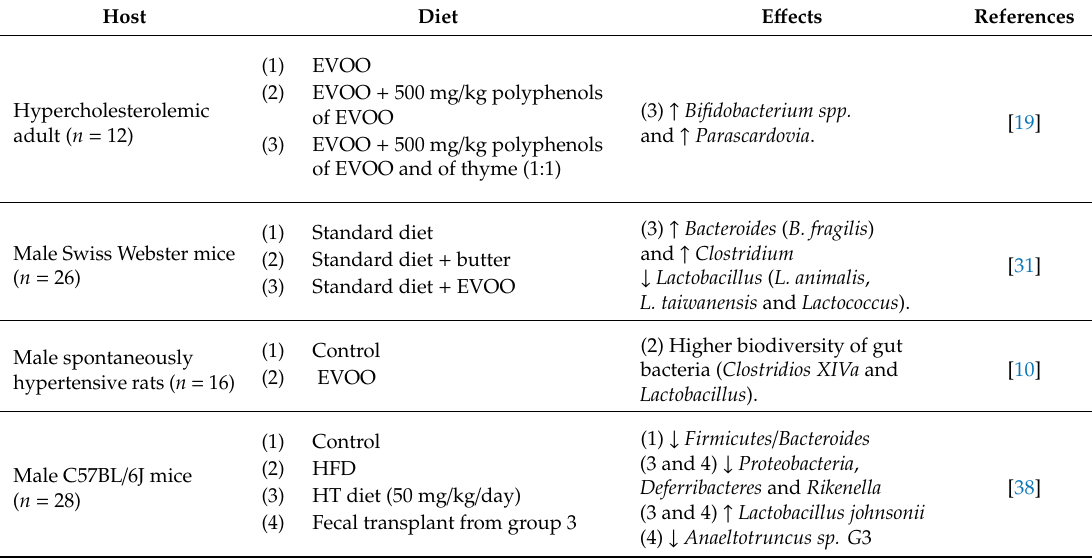
Table 3. E ff ects of the consumption of olive oil and its minor compounds on the gut microbiota. Host Diet E ff